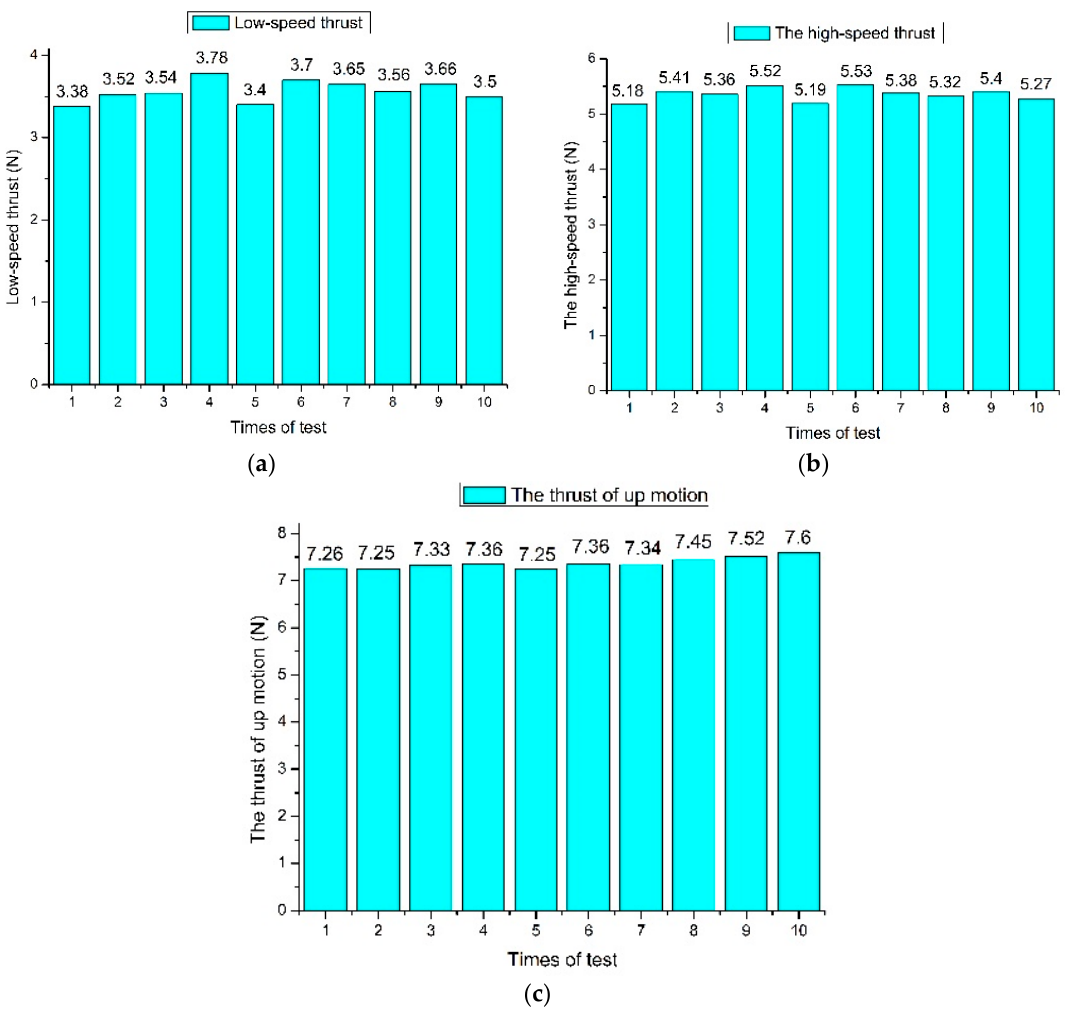
Figure 19. The average propulsive force of different experimental cases. ( a ) Case I; ( b ) Case II; ( c ) Case III.